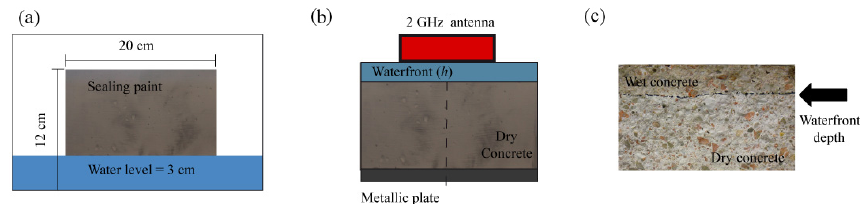
Figure 1. (a) Concrete samples immersed into 3cm of water; (b) GPR acquisition procedure; (c) waterfront marked in the sample after conducting GPR measurements and breaking the sample.